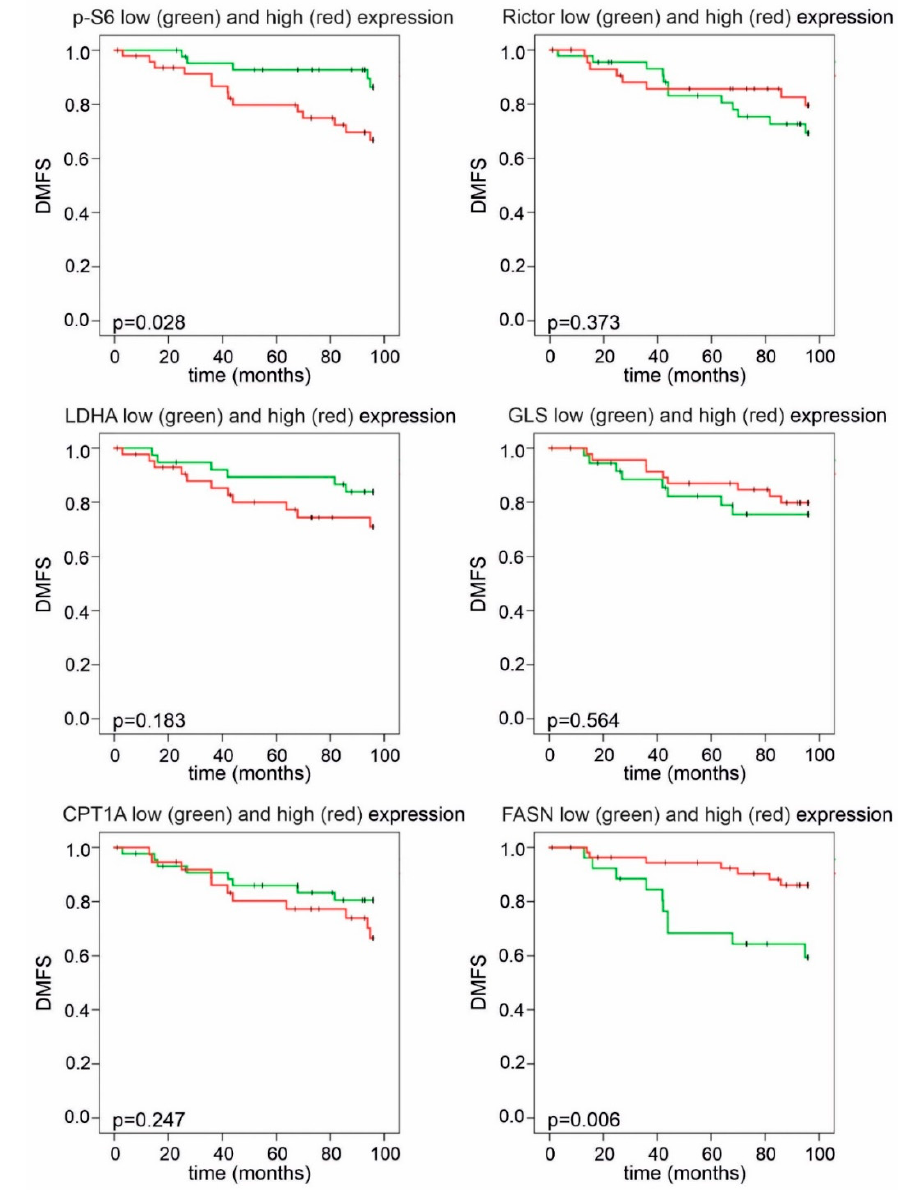
Figure 6. Kaplan–Meier analysis of distant metastasis-free survival in patient groups with high and low IHC scores. Patients with high p -S6 or low FASN H-scores had significantly shorter distant metastasis-free survival (DMFS) during a 96-month follow-up. High LDHA H-scores showed a tendency for worse survival. Low and high groups were determined based on median H-scores. The cut-off value was 150 for p -S6, LDHA, GLS and Rictor and 200 for FASN and CPT1A expression ( p < 0.05 was considered statistically significant).